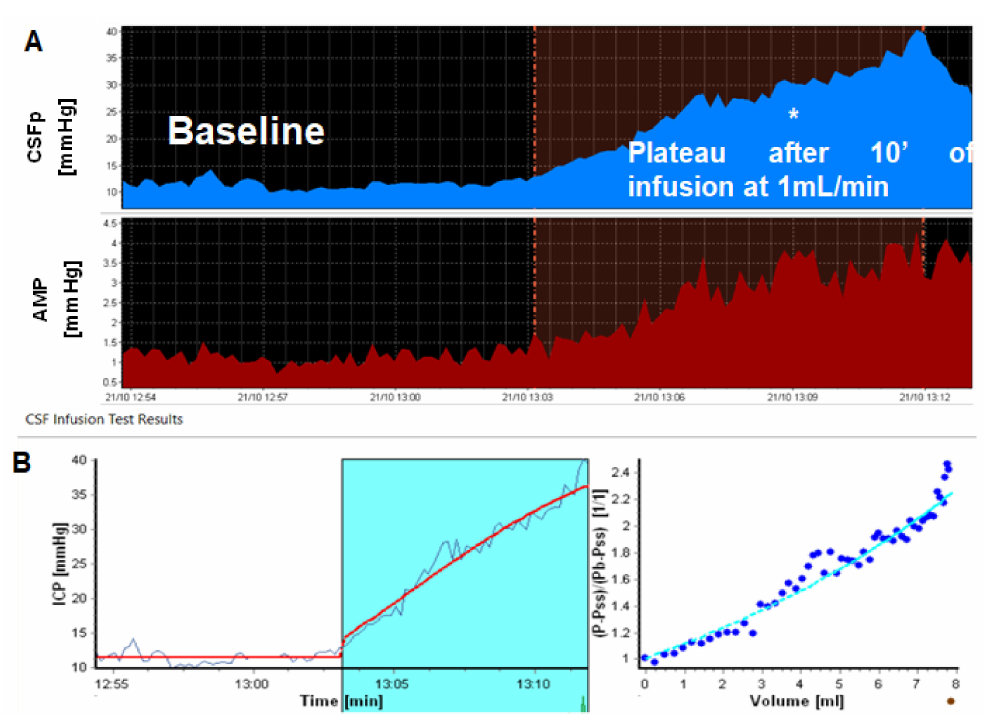
Figure 3. Resistance to CSF outflow (Rout): calculation based on the static formula (ICPplateau—ICP baseline)/Infusion rate ( A —note that ICPplateau is not always stable, as indicated by *) and dynamic method of non-linear curve fitting (both rise in ICP during the test and derived pressure-volume curve) to a theoretical model built in to ICM + ( B ). ICP/CSFp: Intracranial Pressure/Cerebrospinal fluid pressure. AMP: fundamental amplitude of ICP. On lower panel y axis, the formal (P-Pss)/(Pb- Pss) represents measured pressure (P) during infusion, pressure of the sagittal sinus (Pss), and baseline pressure